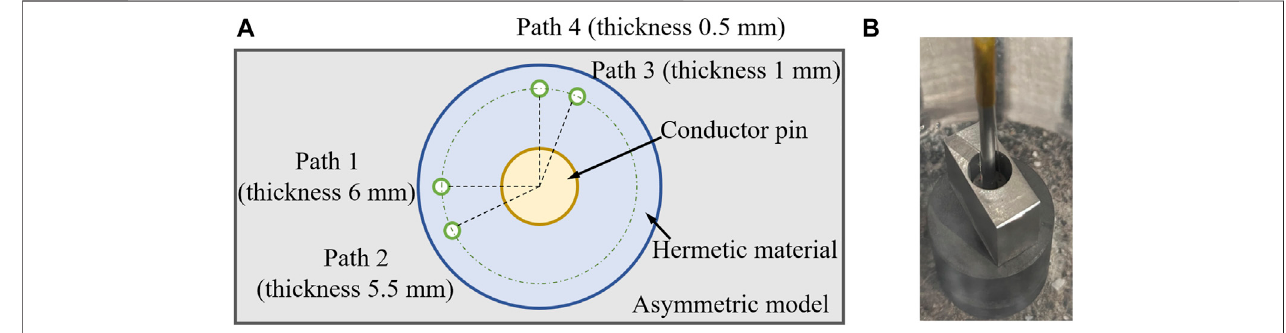
FIGURE 4 | Experimental setup for the asymmetric model with distributed FBGs: (A) the schematic diagram and (B) the photograph.